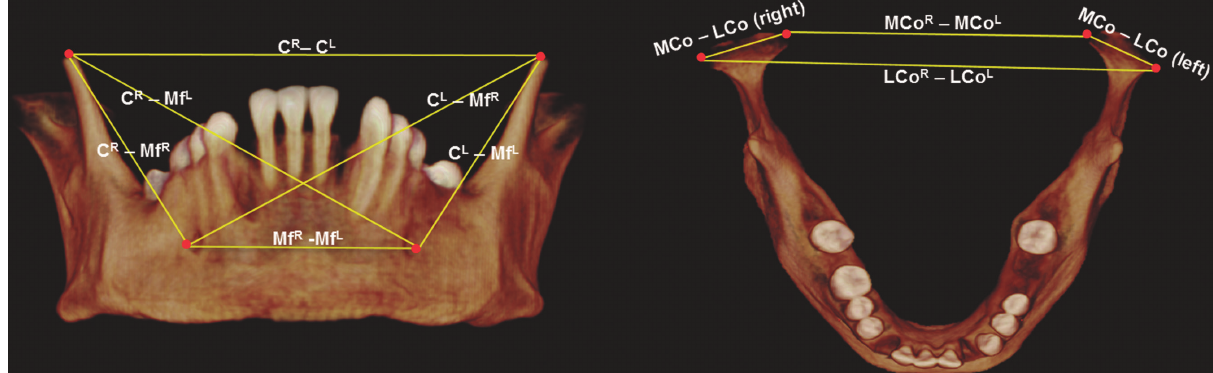
Figure 1- Frontal (left) and sagittal (right) views of mandible showing the points